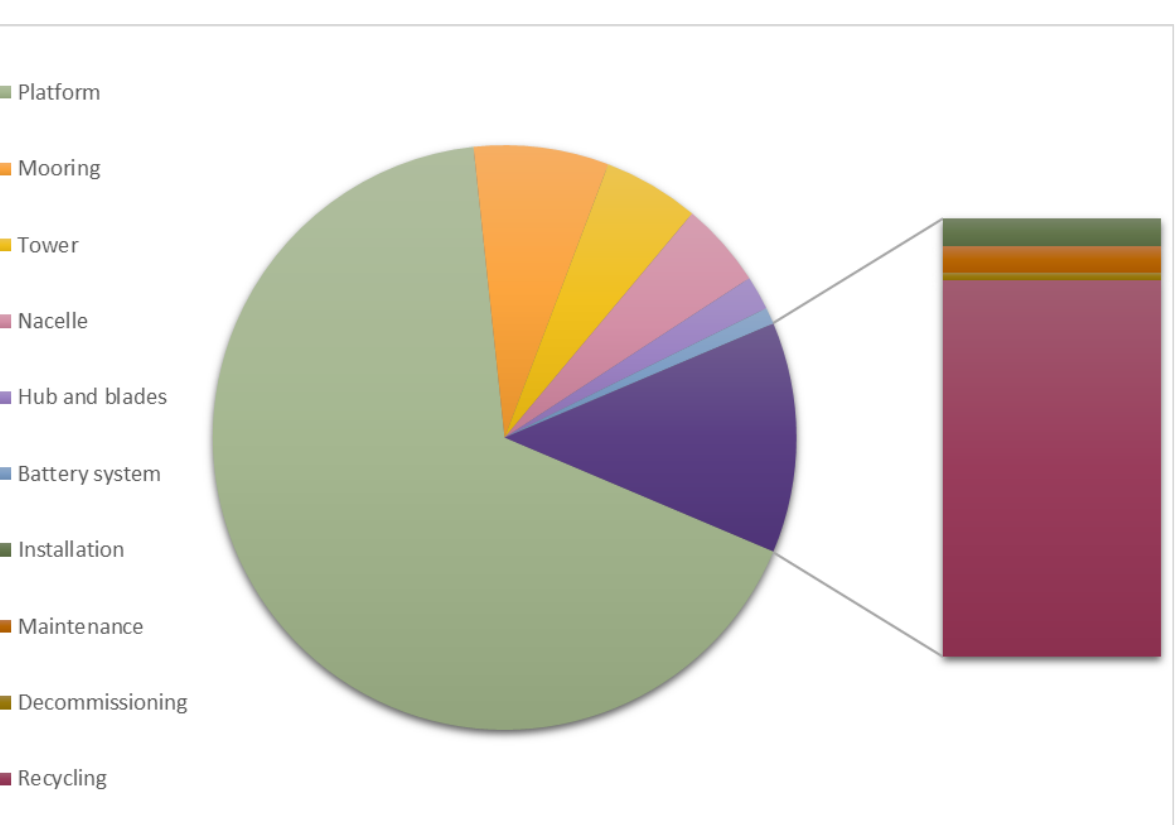
Figure 4. CO 2 emissions for each stage of the project lifecycle. Corresponding percentages: Platform 66.9%, mooring system 7.5%, tower 5.3%, nacelle 4.7%, hub and blades 1.9%, battery system 0.9%, installation 0.8%, maintenance 0.8%, decommissioning 0.2%, recycling 10.9%.